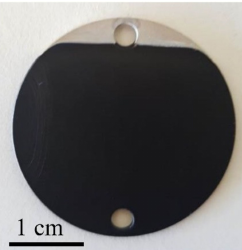
Figure 6. Nickel-plated brass sample with black nickel coating deposited from the optimized procedure